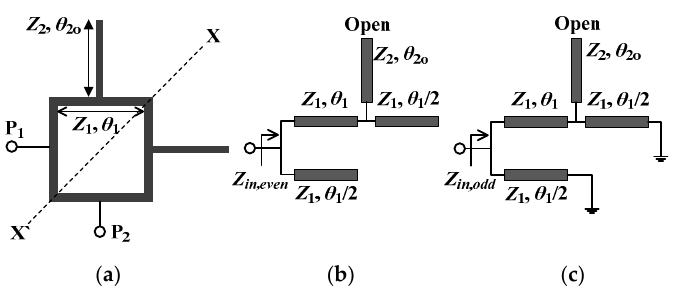
Figure 1. ( a ) Ring resonator with λ g /4 open-ended stubs, ( b ) Even-mode equivalent circuit, ( c ) Odd-mode equivalent circuit.